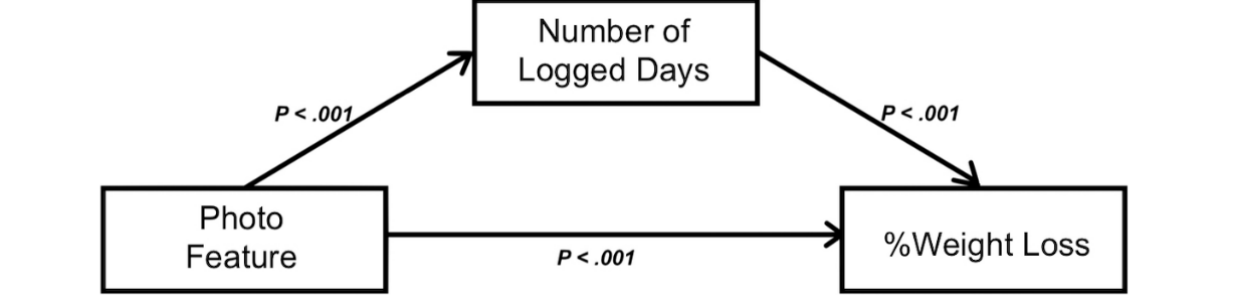
Figure 4. Number of logged days as a mediator. The photo feature use was significantly associated with weight loss (P<.001) before adding the potential mediator, number of logged days, as a covariate. The photo feature was also significantly associated with the number of logged days (P<.001), and the number of logged days was significantly associated with weight loss (P<.001). Direction of significance was reversed when adjusted for the number of logged days (P<.001), indicating that the number of logged days was a